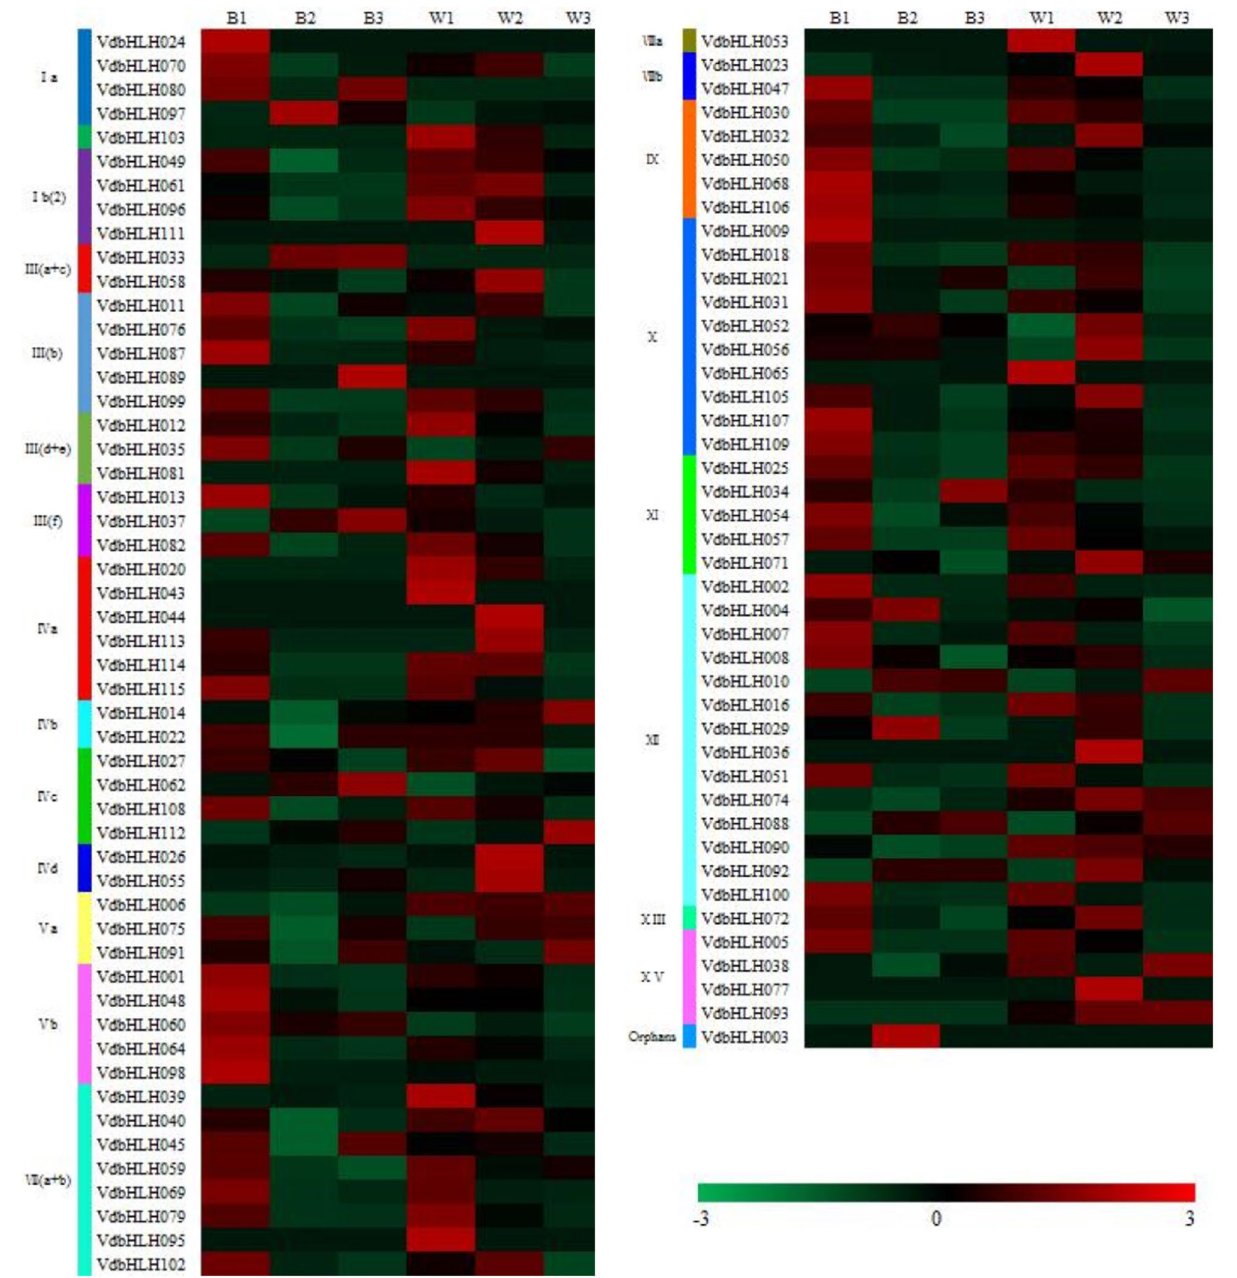
Figure 5. The heatmap of black and white spine grape berry bHLH genes at different developmental stages. Note : B1, B2 and B3 represent black spine grape berry of 40, 80 and 120 days after anthesis, respectively. W1, W2 and W3 represent white spine grape berry of 40, 80 and 120 days after anthesis,